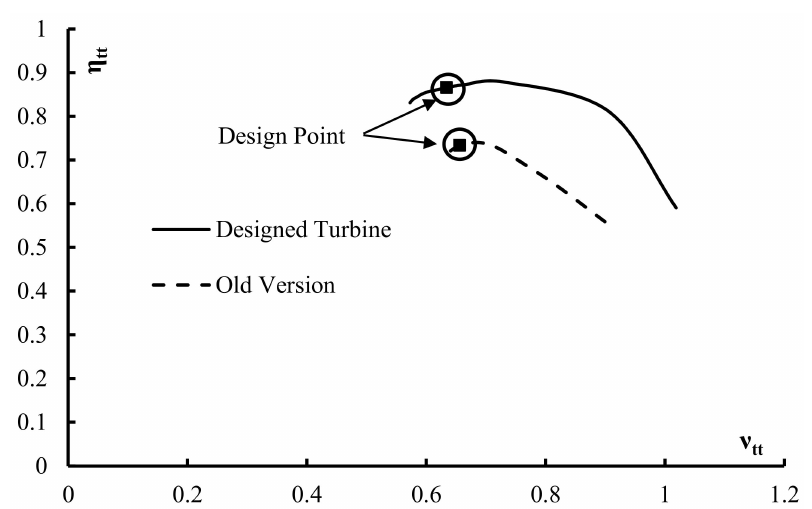
Figure 14. Mass flow rate map for the new design of RI turbine.